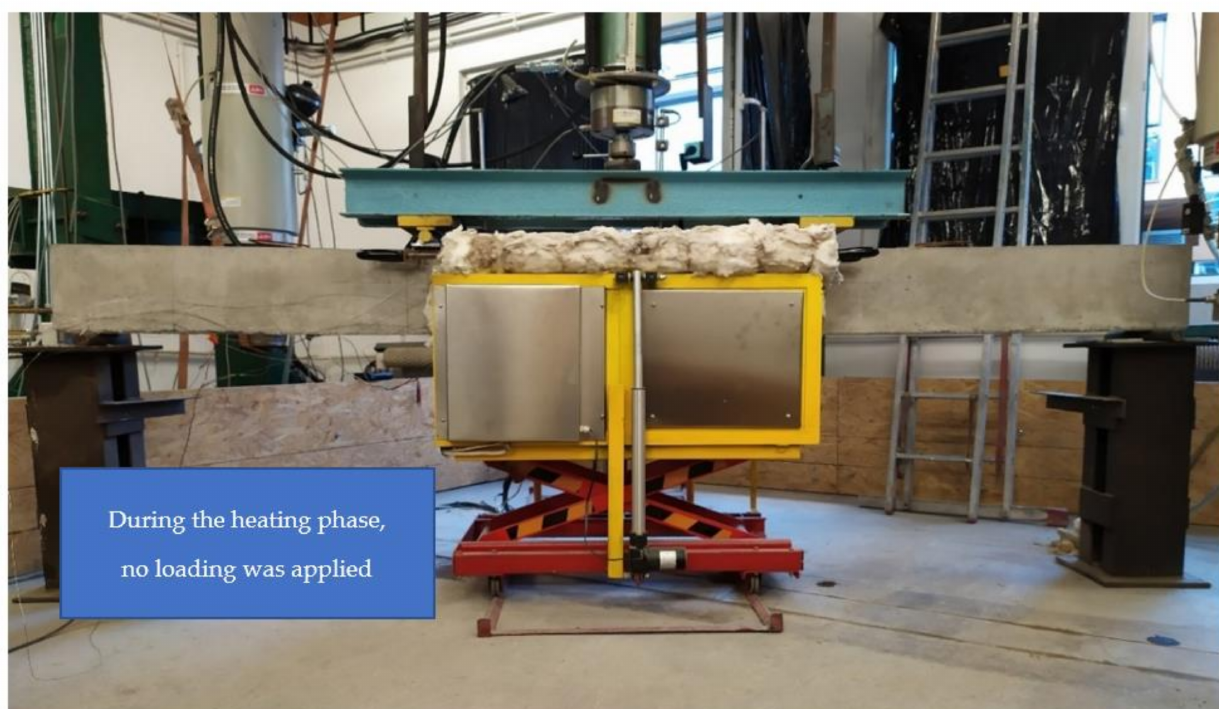
Figure 3. Test setup during the heating phase (set 1.1—sample